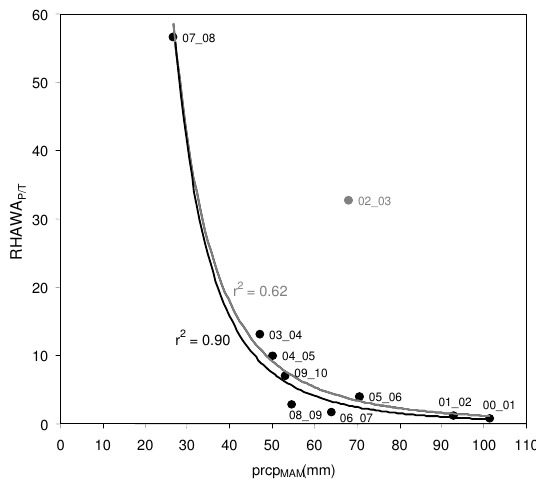
Fig. 12. Relation between prcp MAM and R HAWA P / T . Grey fitted line is based on R HAWA P / T and prcp MAM for all years ( r 2 : 0.62) and black fitted line was computed without 02 03 (highest snow cover) ( r 2